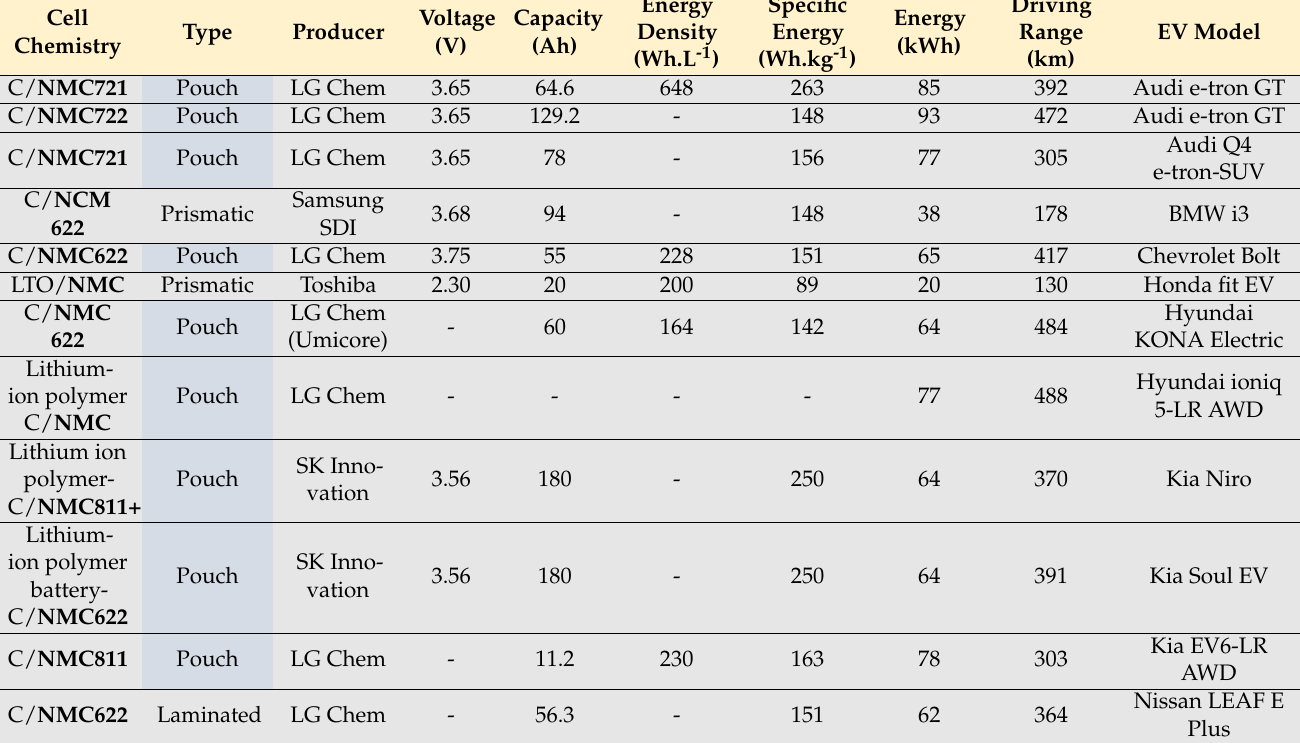
Table 1. Various lithium-ion battery chemistries for EVs. LTO: Li 4 Ti 5 O 12 , C: graphite; Si: silicon;